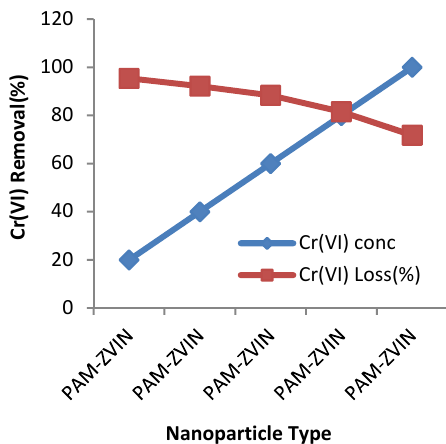
Fig.11.The removal efficiency of Cr(VI) using PSS- ZVINs as a function of Cr(VI) concentrations